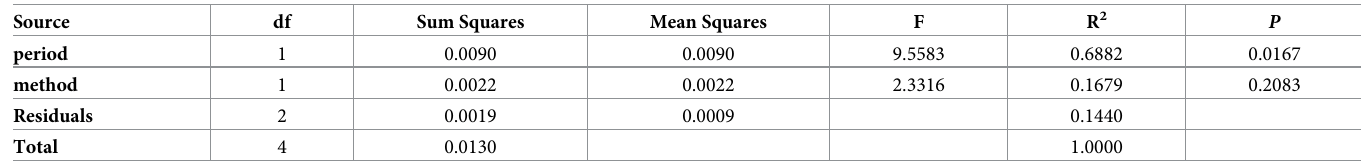
Table 2. The results of the permutational multivariate analysis of variance using distance matrices of Emberiza bunting communities in Korea. Source df Sum